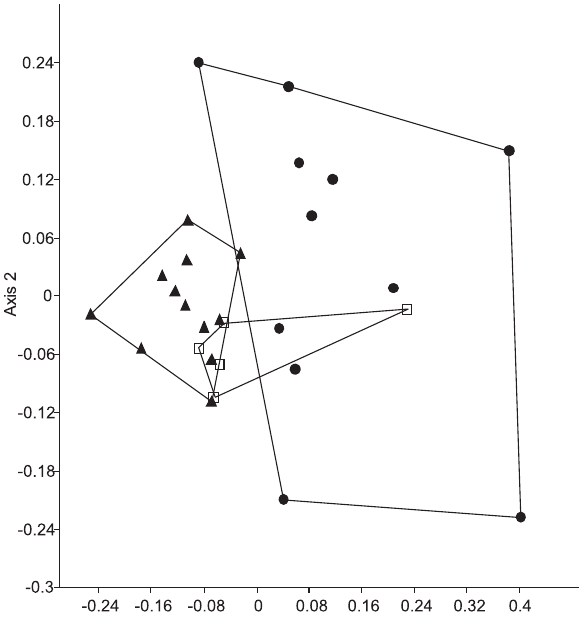
Figure 5. Unweighted Pair-Groups Method using arithmetic Avera- ges plot of faunal similarity among sites in three vegetation types in an Atlantic Forest area, based on the Bray-Curtis index. (G) Grass- land, (E) edge, (F) forest. For site numbers see Table I. Grassland site number 10 was excluded from the study because no moths were